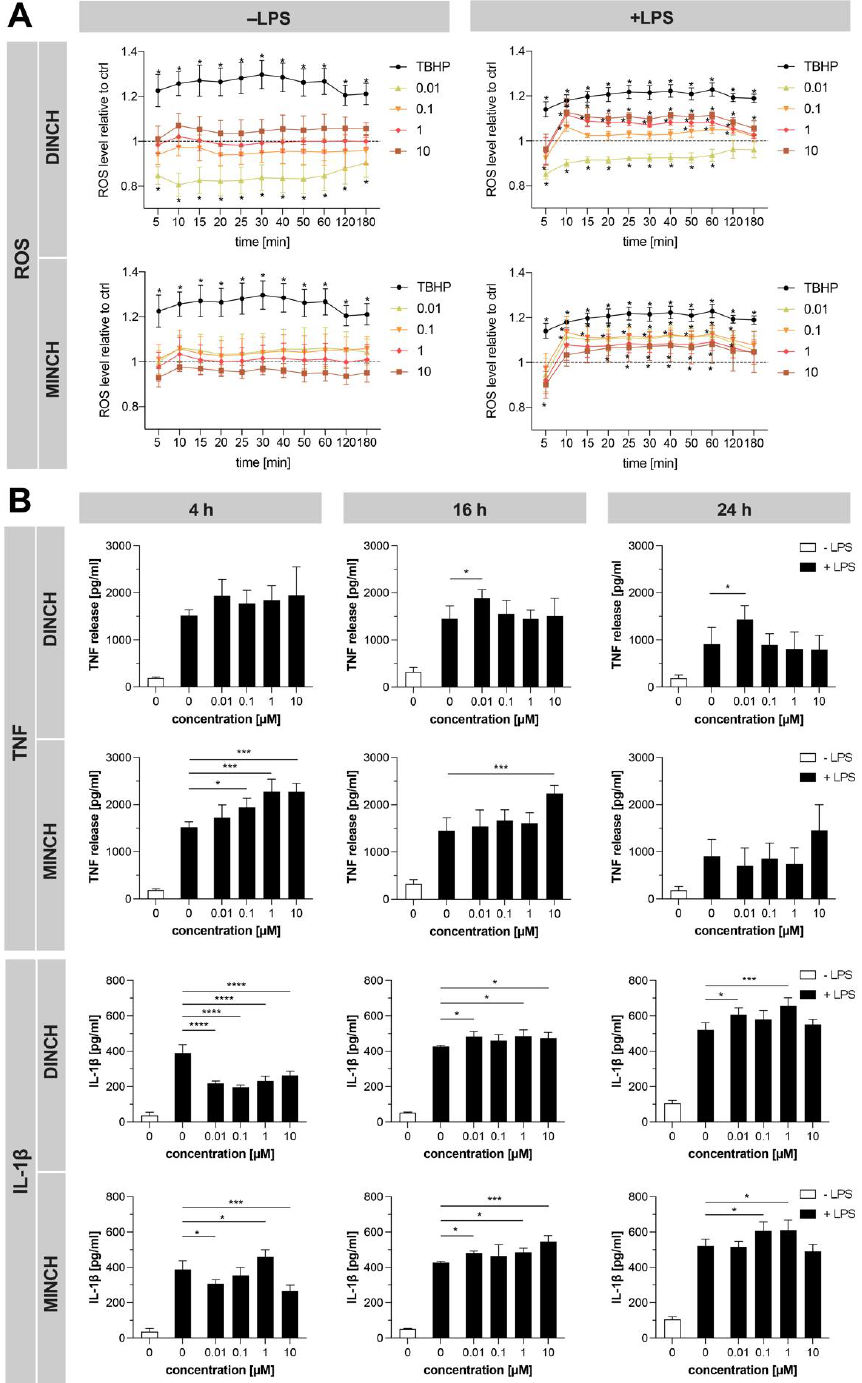
Figure 4. Effect of DINCH and MINCH on intracellular ROS levels and cytokine release. ( A ) ROS levels were measured after THP-1 M1-like macrophage incubation with 20 µM DCFDA for 45 min and treatment with DINCH, MINCH or the positive control TBHP. ROS levels were monitored over 180 min and are shown as ratio to the corresponding control with or without LPS containing equivalent amounts of MeOH Ratios are shown as mean ± SD, n = 4. Significant changes are labeled with asterisks (* p ≤ 0.05) ( B ) Differentiated THP-1 cells were treated with increasing concentrations of DINCH and MINCH for 4, 16, and 24 h. TNF and IL1- β release was determined in the cell culture supernatant using ELISA and is displayed as mean ± SD, n = 4. Significant changes are labeled with asterisks (* p ≤ 0.05, *** p ≤ 0.001 , **** p ≤ 0. 0001).